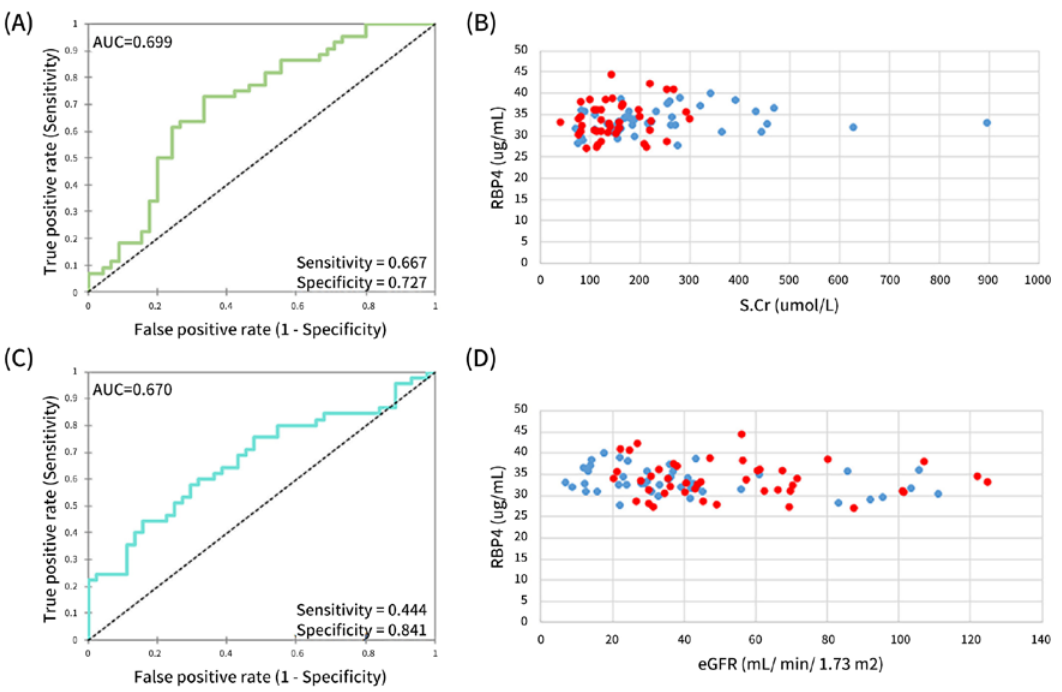
Figure 5. Ratio index as discriminatory marker between the 2 CKD diseases using direct RBP4 values. ROCs showing performance of RBP4:S.Cr ratio ( A ) and RBP4:eGFR ratio ( C ) as discriminatory markers for CKD and CKDu. Distribution of RBP4:S.Cr ( B ) and RBP4:eGFR ratios ( D ) in CKD (blue) and CKDu (red). Direct values of RBP4 are